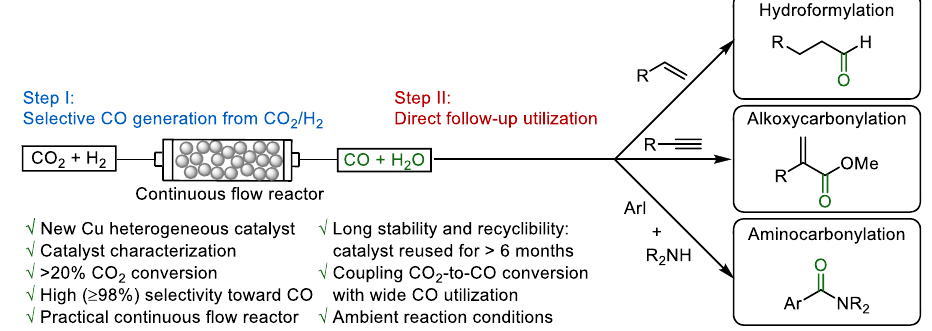
Fig. 1 | Catalytic carbonylations using carbon dioxide. Selective copper-catalyzed CO generation from CO 2 and direct utilization in carbonylation reactions. Table 1 | CO 2 hydrogenation to CO over different Cu-based catalysts in continuous- fl ow reactor